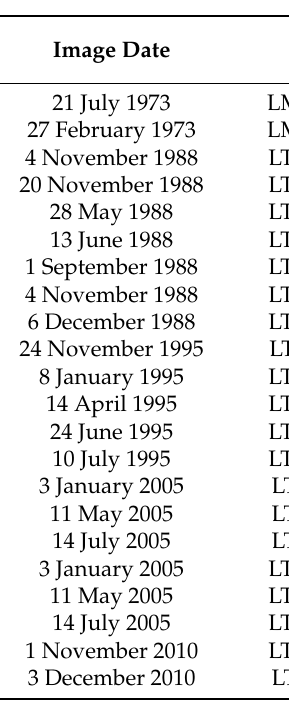
Table 1. Landsat images used for the LULC change